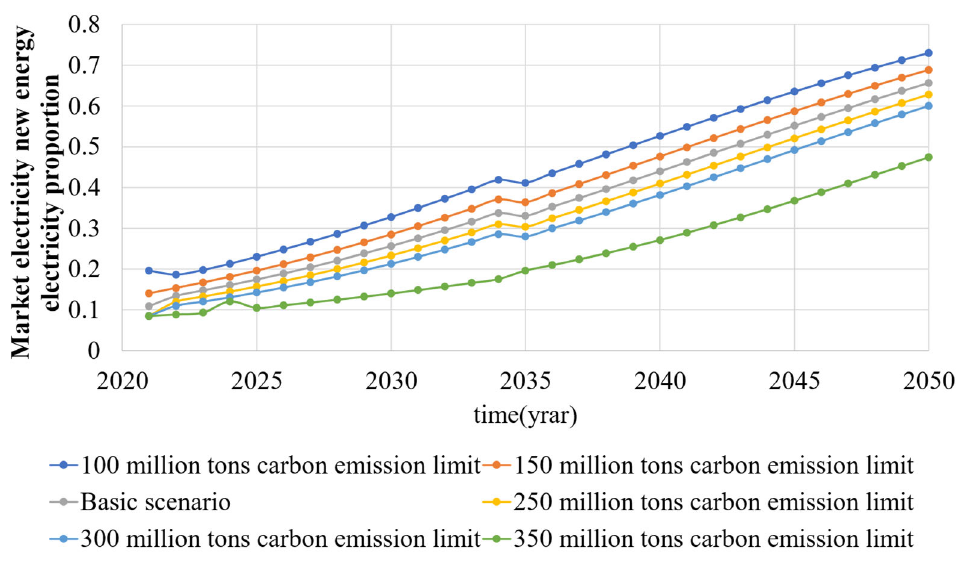
Figure 13. Sensitivity analysis and simulation results of electricity proportion of market ‐ oriented renewable energy generation based on carbon emission limit.